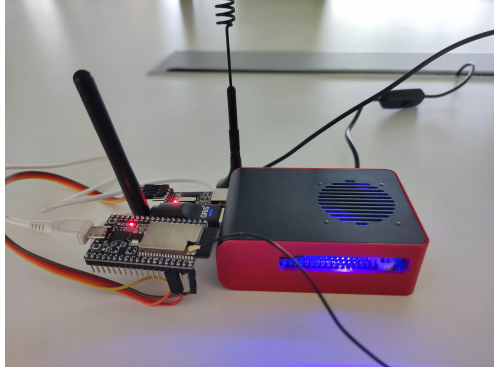
Figure A1. Physical picture of CSI collection equipment.